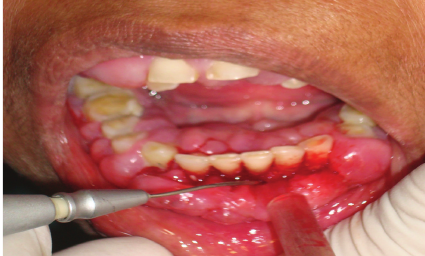
Figure 4: Excised specimen sent for histopathological